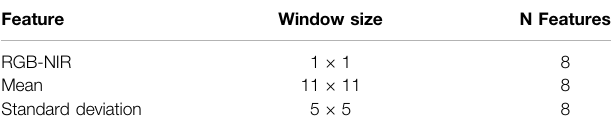
TABLE 1 | List of image